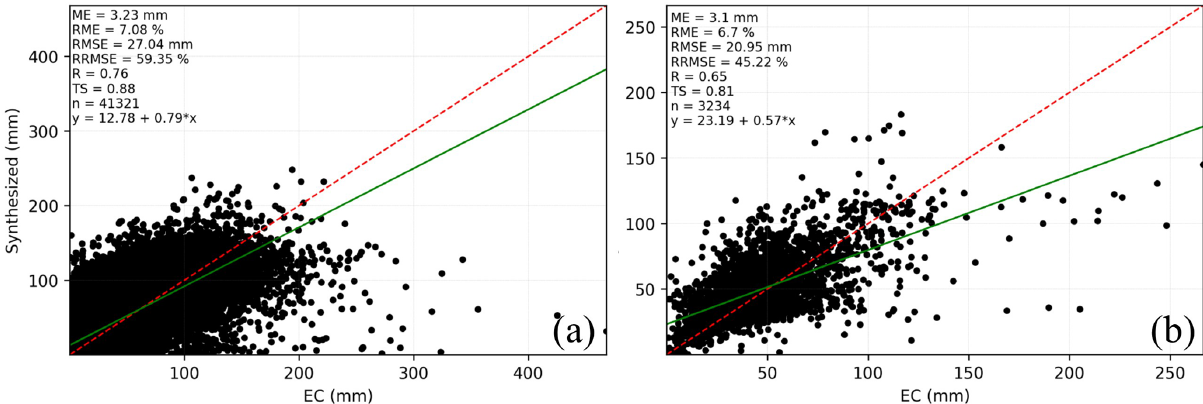
Figure 15. Monthly (a) and annually (b) synthesized ET against flux EC ET aggregated for all sites.